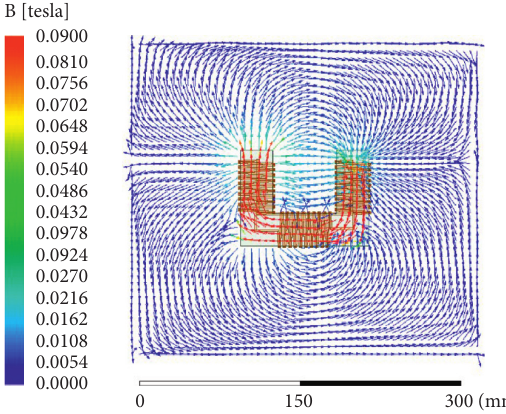
Figure 3: Distribution of magnetic induction intensity of the primary U-shaped core